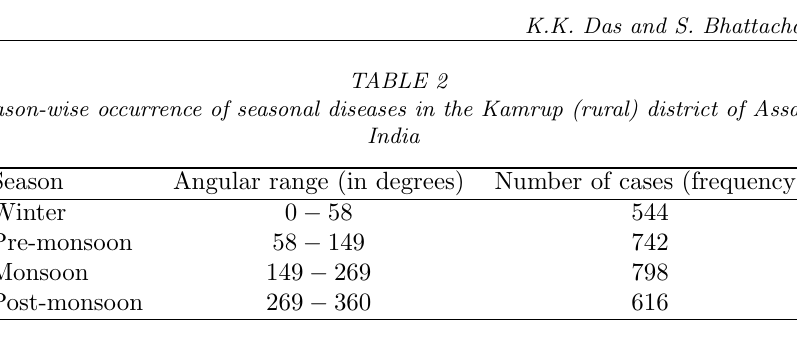
Censored Circular Descriptive Statistics for data shown in Table (1)